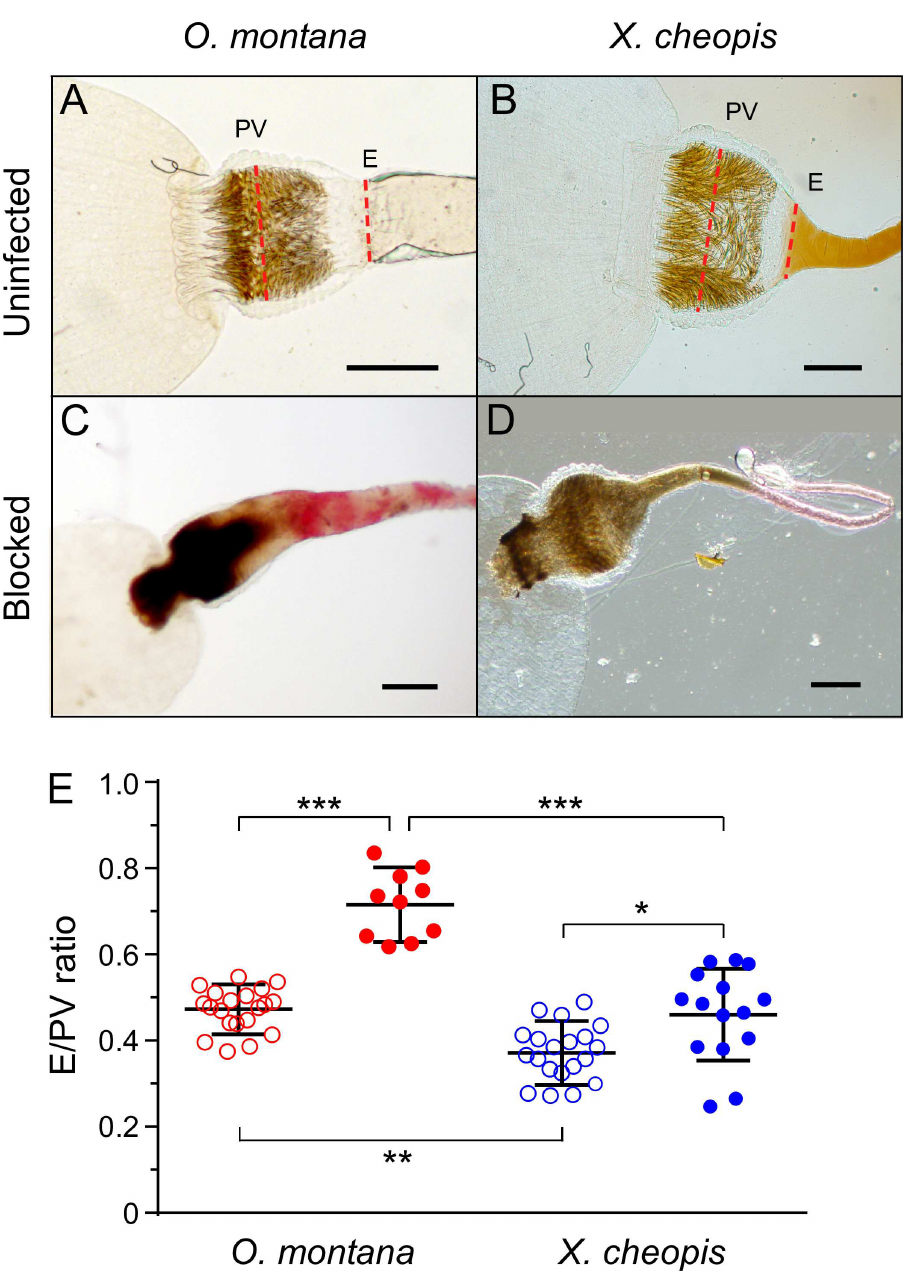
Fig 5. Proventricular blockage causes greater esophageal distension in O . montana than in X . cheopis . ( A-D ) Representative images of foreguts from dissected uninfectedand blocked O . montana and X . cheopis .Dashedred lines indicatethe locationof esophageal (E) and proventricular (PV) measurements used to calculatethe E:PV ratio of uninfectedfleas (open symbols; n = 20) and blockedfleas (closed symbols; n = 10 to 15) in ( E ); the mean and SD are indicated. * P < 0.05; ** P < 0.01, *** P < 0.0001 by one-way ANOVA and Tukey’s multiple comparison test. Scale bars = 100 μ